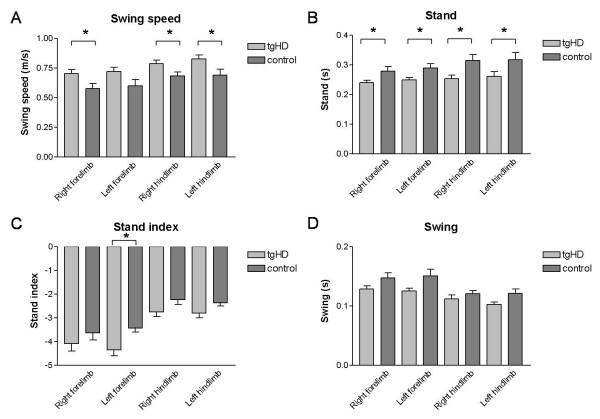
Catwalk automated gait analysis test of tgHD and littermate control rats at two months of age. (A) Shows the swing speed of all limbs for tgHD (light) and control rats (dark). (B) Duration of paw contact of all limbs for tgHD and control rats. (C) Speed at which the limbs lose contact with the glass plate for tgHD and control rats. (D) Swing time of all limbs for tgHD and control rats. Data are shown as mean ± s.e.m. * p < 0.03.